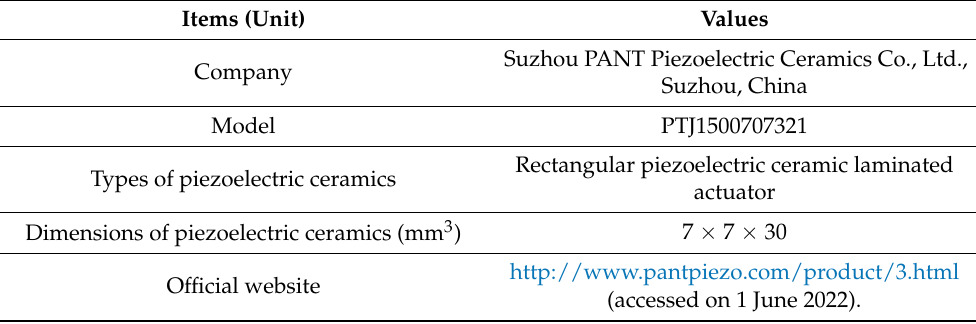
Table 3. The specific information of the piezoelectric ceramics used in this study. Items